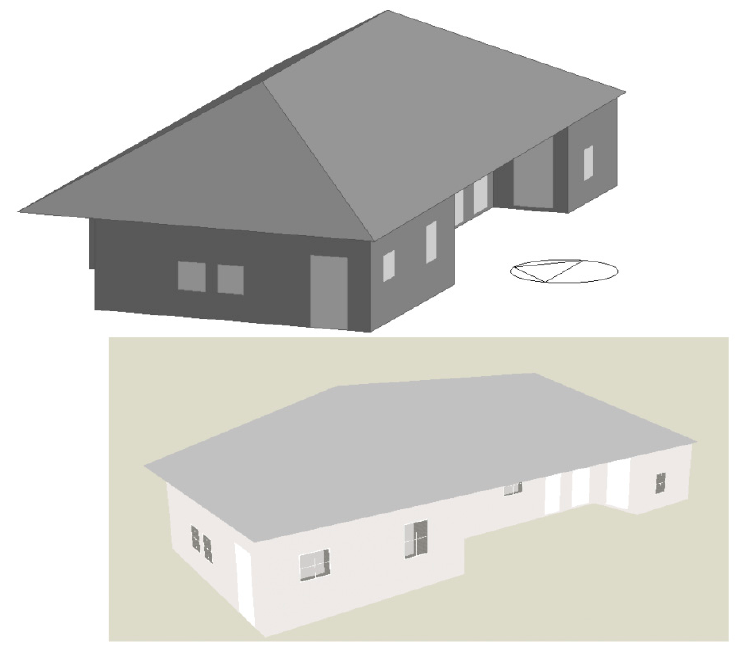
Figure 3. Building modeled with Design Builder tool.